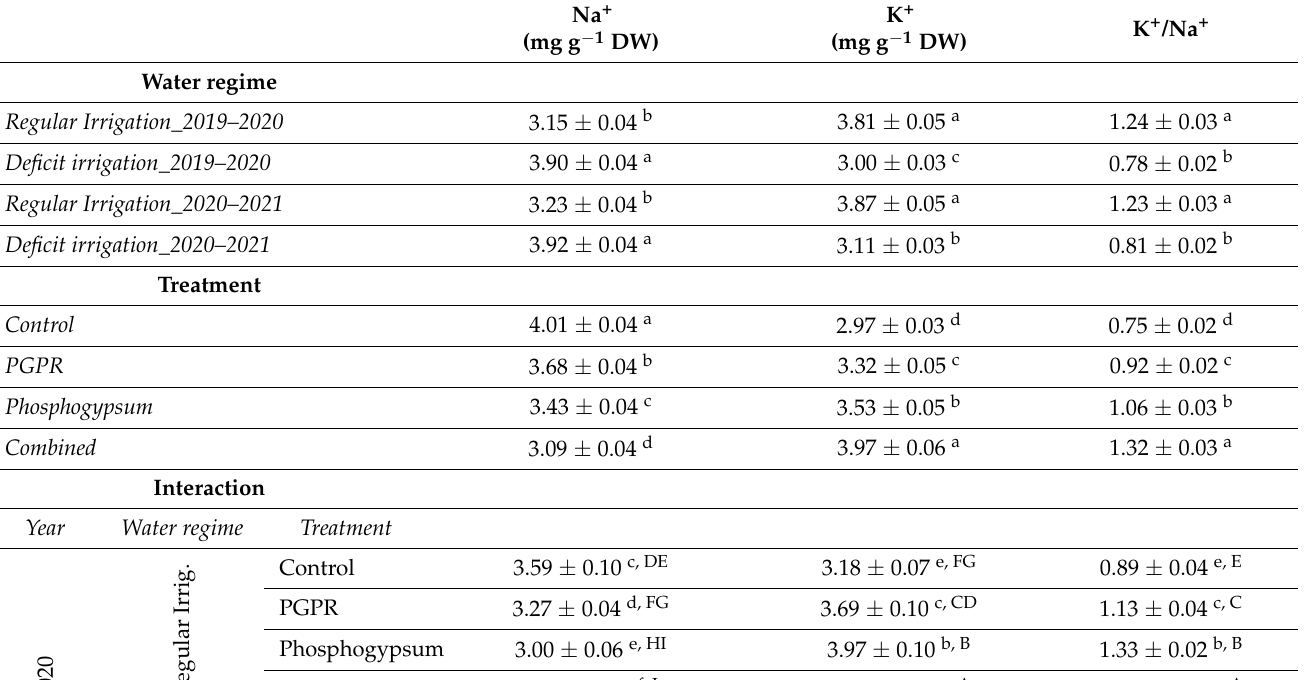
Table 2. Uptake of Na + , K + , and K + /Na + ratio in leaves of quinoa plants grown in the presence of different water regimes and treated with phosphogypsum, plant growth-promoting rhizobacteria, or